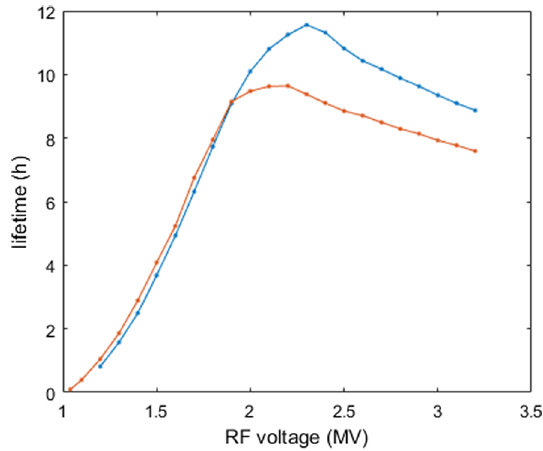
FIG. 15. Measured Touschek lifetime before (blue) and after the installation of DDBA cell